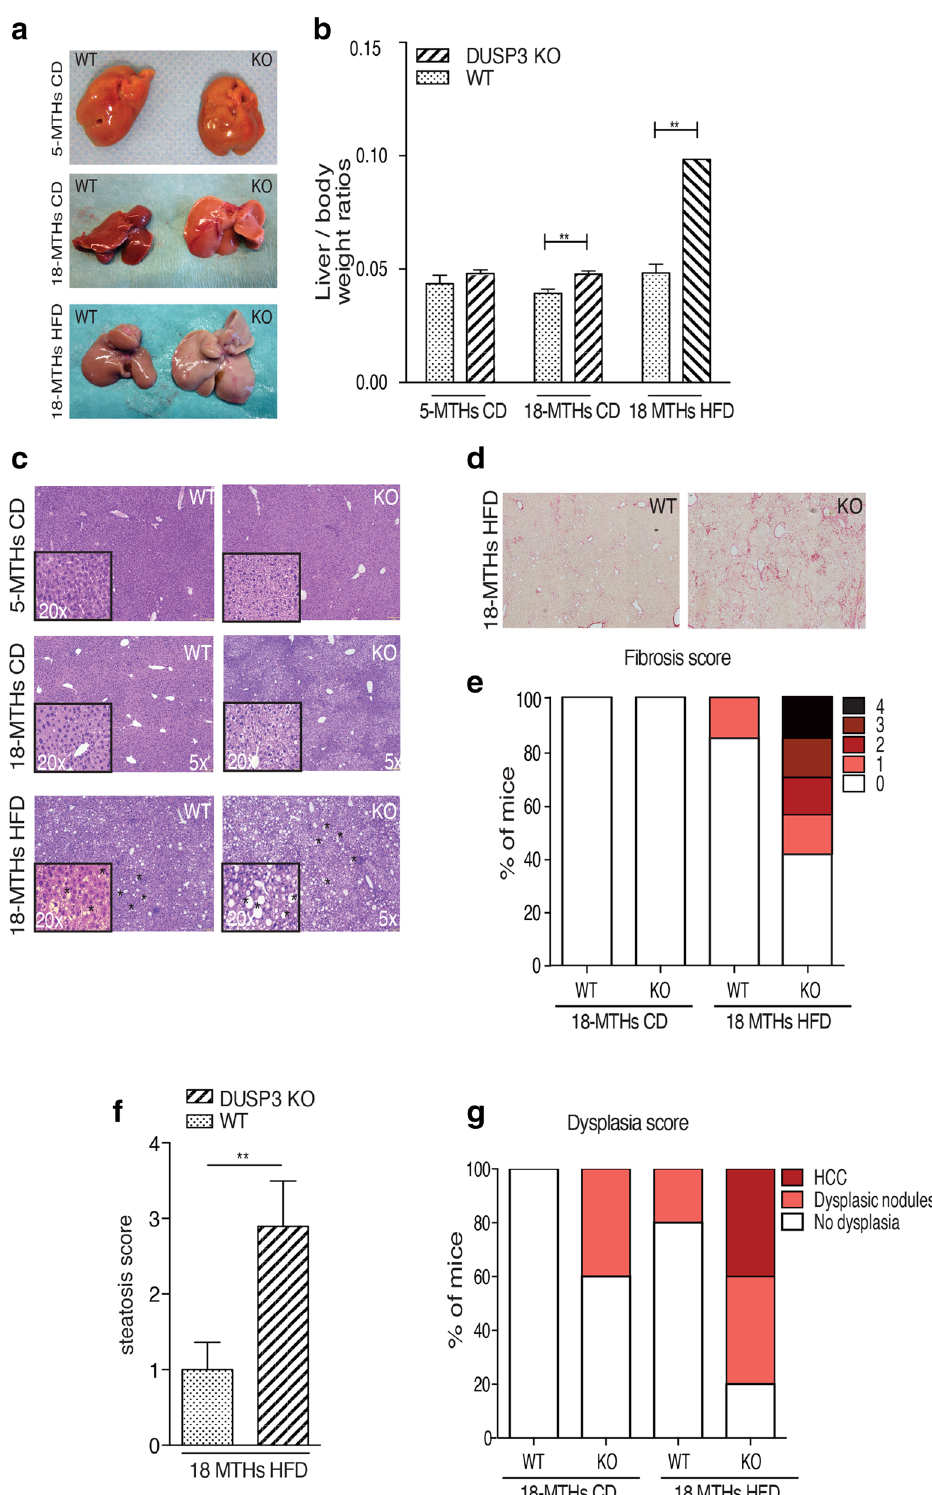
Figure 3. DUSP3 deletion promotes NAFLD and associated liver damages. ( a ) Representative image of liver from mutant and WT mice fed CD or HFD. ( b ) Quantification of liver to body weight ratio. Data represent the mean ± SD of at least ten mice of each of the indicated group (**P < 0.01). ( c ) Representative images of H&E staining of liver sections from DUSP3-KO and WT fed CD or HFD. Asterisks indicate representative lipid droplets. ( d ) Representative images of Sirius Red staining of liver sections from DUSP3-KO and WT fed HFD. ( e–g ) Fibrosis ( e ), steatosis ( f ) and dysplasia ( g ) scores. Mean ± SD values for all mice are shown. *P < 0.05; **P <